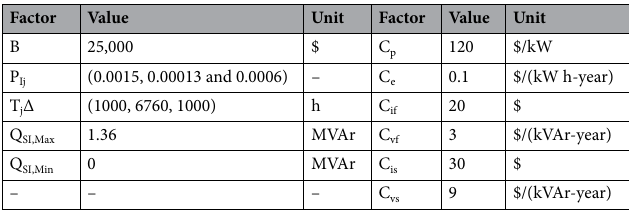
Table 1. The economic information of 24-bus network 20 .